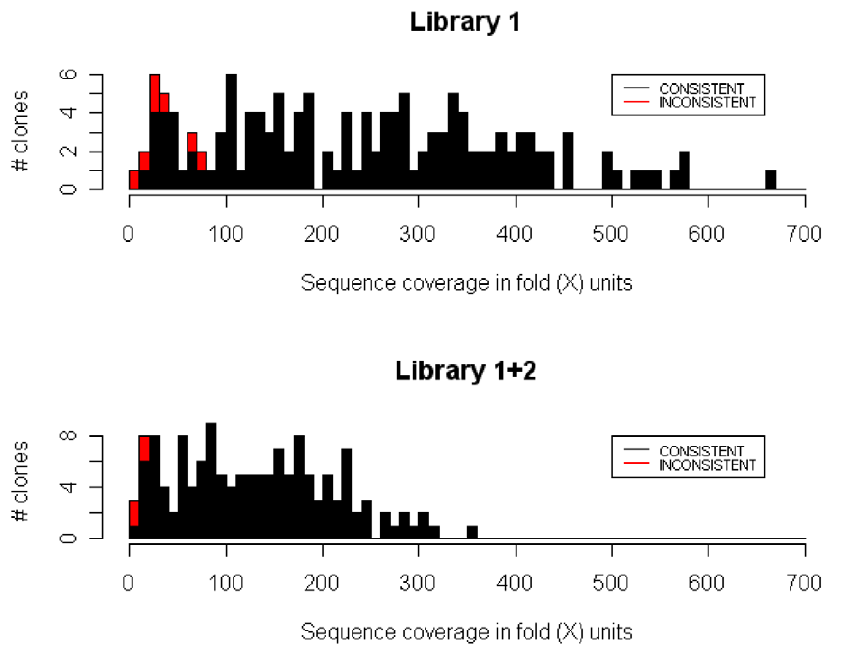
Figure 4. A histogram showing relationship between the sequence coverage for each clone and their assembly result classifications. The histograms show the sequence coverage distribution of clones in Library 1 and 1 + 2. First, we aligned the shotgun reads against the finished reference clone sequences, allowing up to 3 mismatches. Next we calculated the sequence coverage (X-axis) for each clone as follows: ( # of reads aligned with the clone) 6 (read length (36 bp))/(the length of the clone). Y-axis shows the number of clones. Every clone is colored according to its consistency of the CDS structure; a red bar shows the proportion of the inconsistent clones in that range. Clones that were not successfully amplified by PCR are not shown in the histogram, as they always had little sequence coverage by definition. Most of the clones classified as inconsistent had sequence coverage lower than 50 6 , suggesting that inconsistency might have arisen due to lower sequence coverage. doi:10.1371/journal.pone.0010517.g004 PLoS ONE |